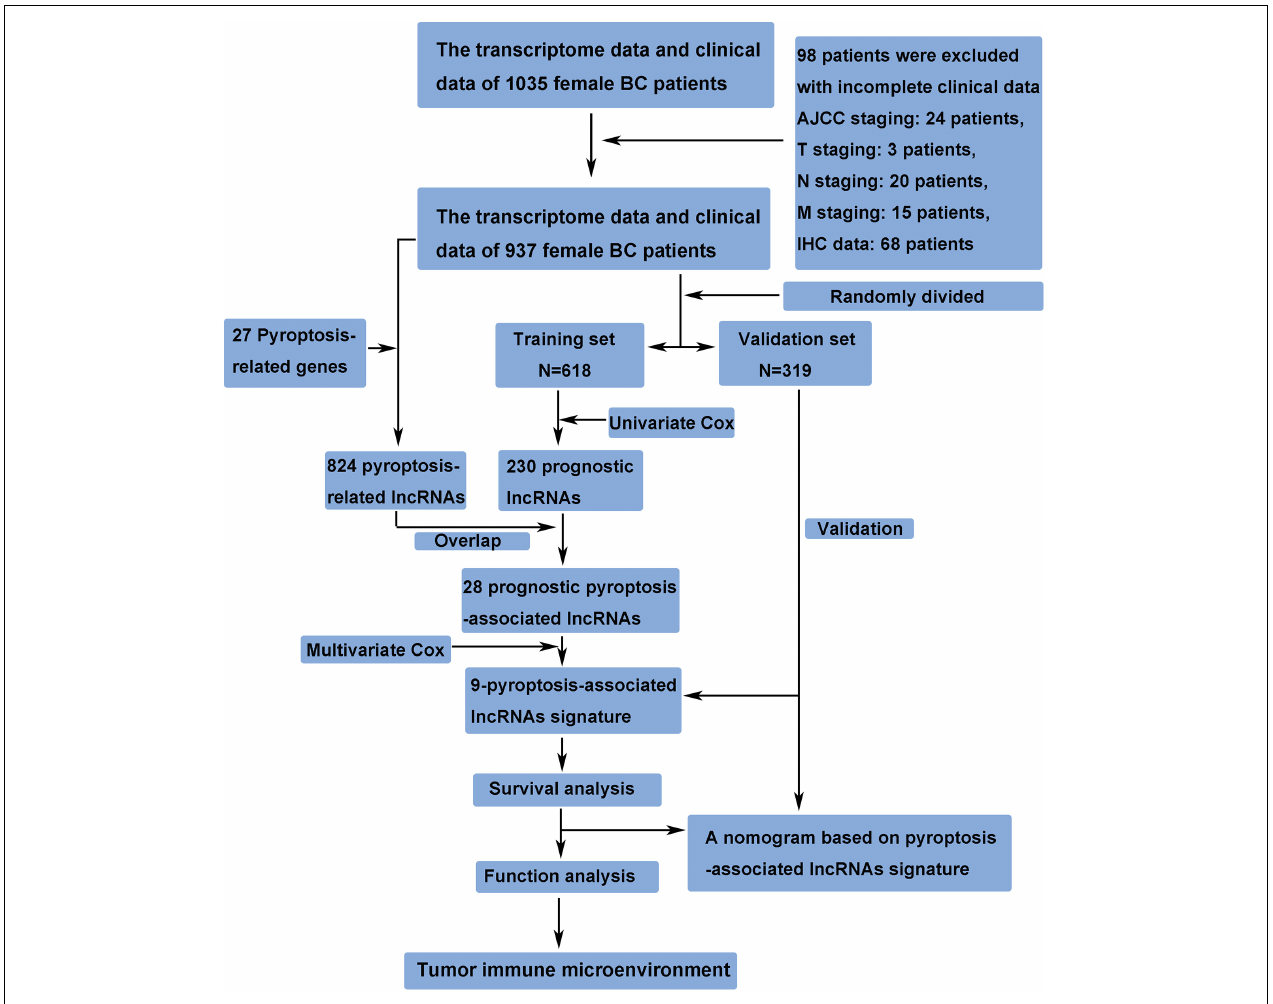
FIGURE 1 | Study design and flowchart of this